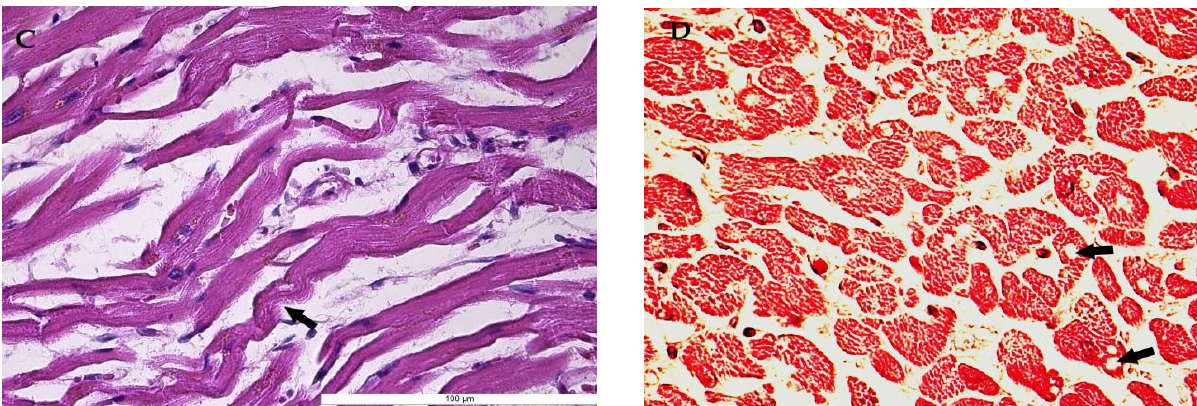
Figure 1. Myocardium microscopic features in hypothermia cases. ( A ) Myocardium with ischemic fibrosis in hypothermia (arrow), Masson’s trichrome staining. ( B ) Loss of normal pattern of organisation in columns of cardiomyocytes, focal wavy myocardial cells (arrow), and degenerative changes with contraction bands, Hematoxylin and eosin (H&E) staining. ( C ) Myocardium with evident wavy myocardial cells (arrow) and few contraction bands, H&E staining. ( D ) Cardiomyocytes vacuolisation (colliquative myocytolysis) (arrow) and blood capillaries, H&E staining ×20.